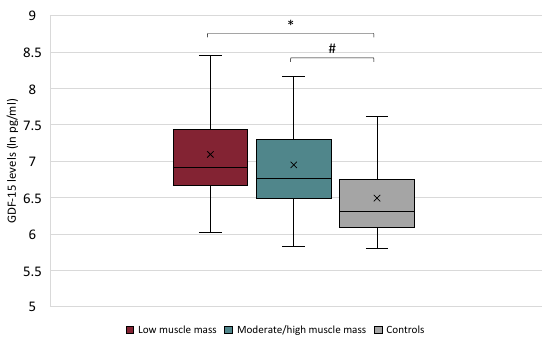
Figure 4. Growth Differentiation Factor 15 ( GDF-15) serum levels in cancer patients with low muscle mass vs. those with moderate/high muscle mass and vs. controls (Kruskal–Wallis test p = 0.0005). * p = 0.0006; # p = 0.0017.